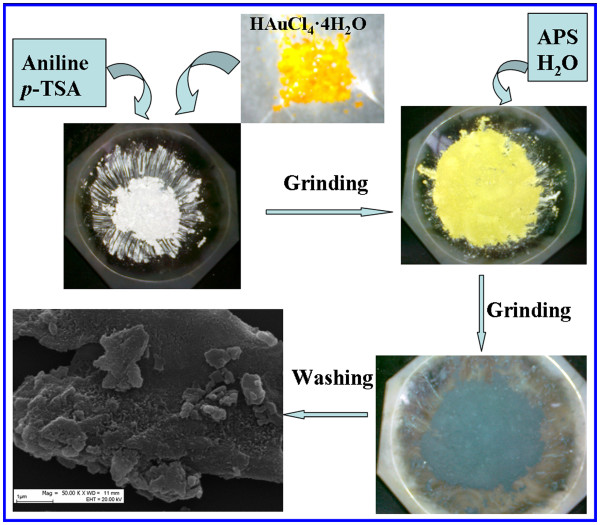
Schematic of solid-state method synthesis of PANI(HAuCl4·4H2O) hybrid material.